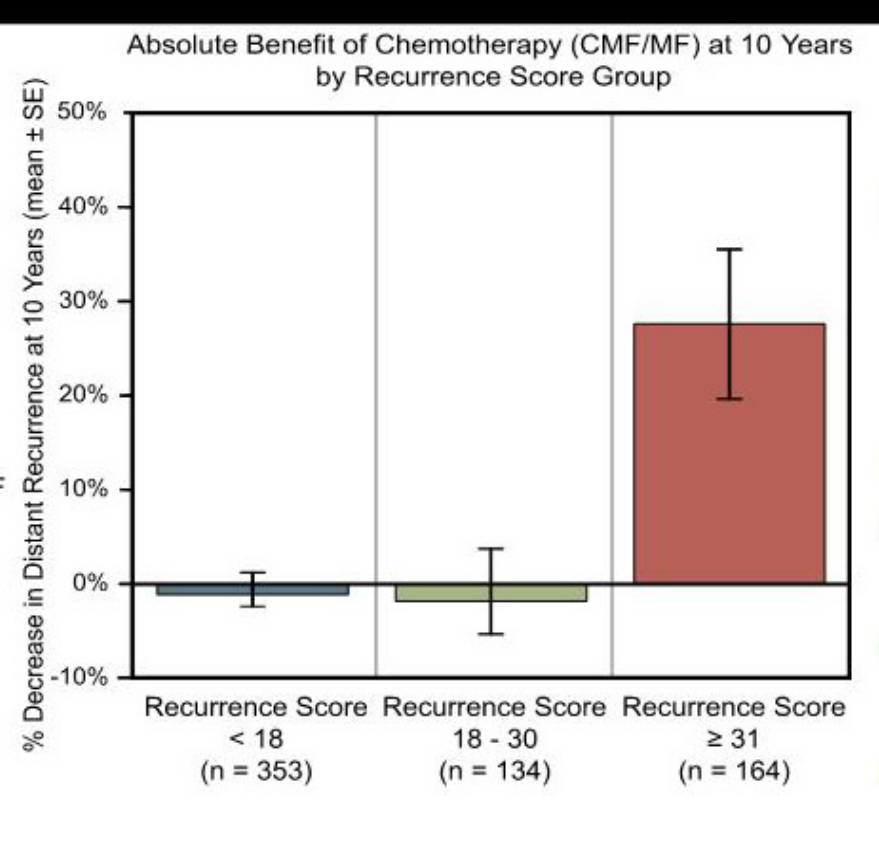
Figure 3. Demonstration of benefit of chemotherapy in patients in high risk group based on genomic